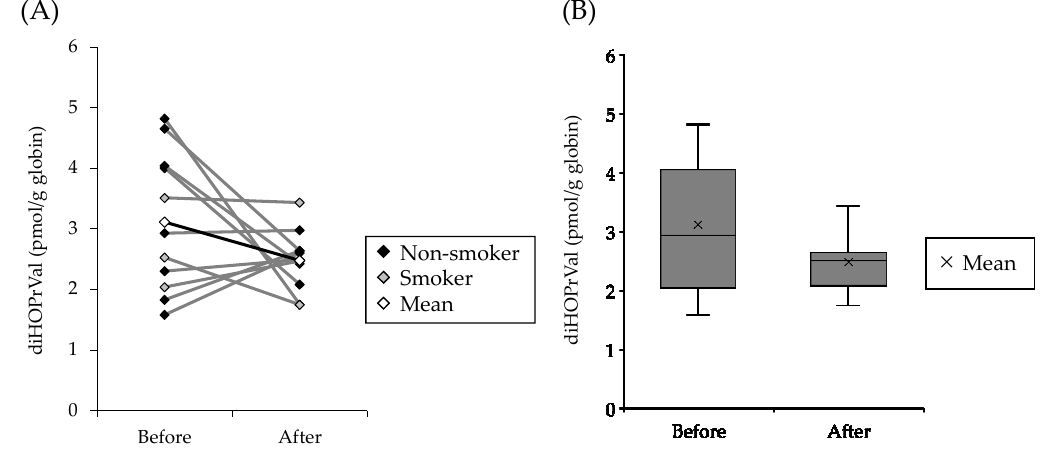
Figure 3. Distribution of individual glycidol-Hb adducts diHOPrVal levels in humans before and after ingestion of pork cooked over charcoal fire. ( A ) Closed rhombus represents individual diHOPrVal. Open rhombus represents average values of diHOPrVal in each group. ( B ) diHOPrVal distribution is illustrated as a box plot showing the median adduct levels with 25, 50, and 75th percentiles presented as vertical boxes and error bars.